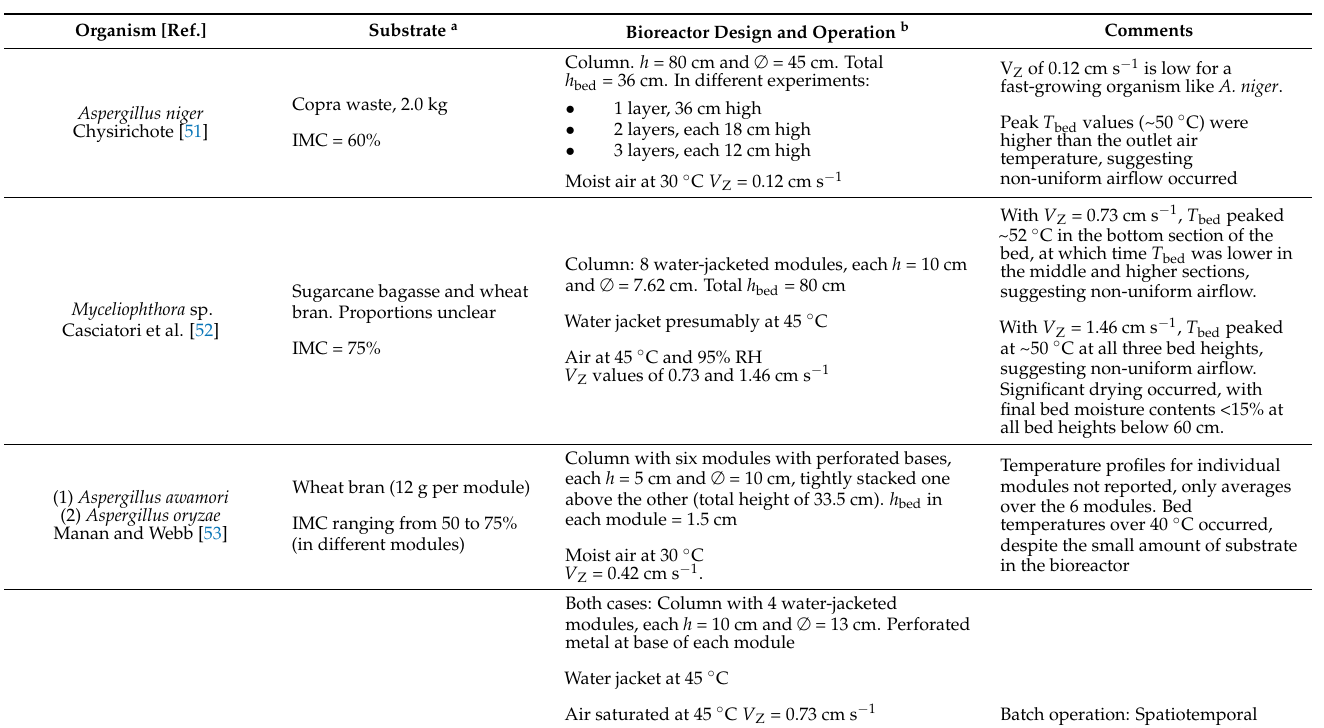
Table 6. Studies of the use of multi-layered packed-bed